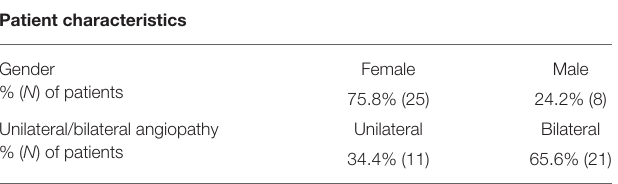
TABLE 1 | Characteristics of all included patients.